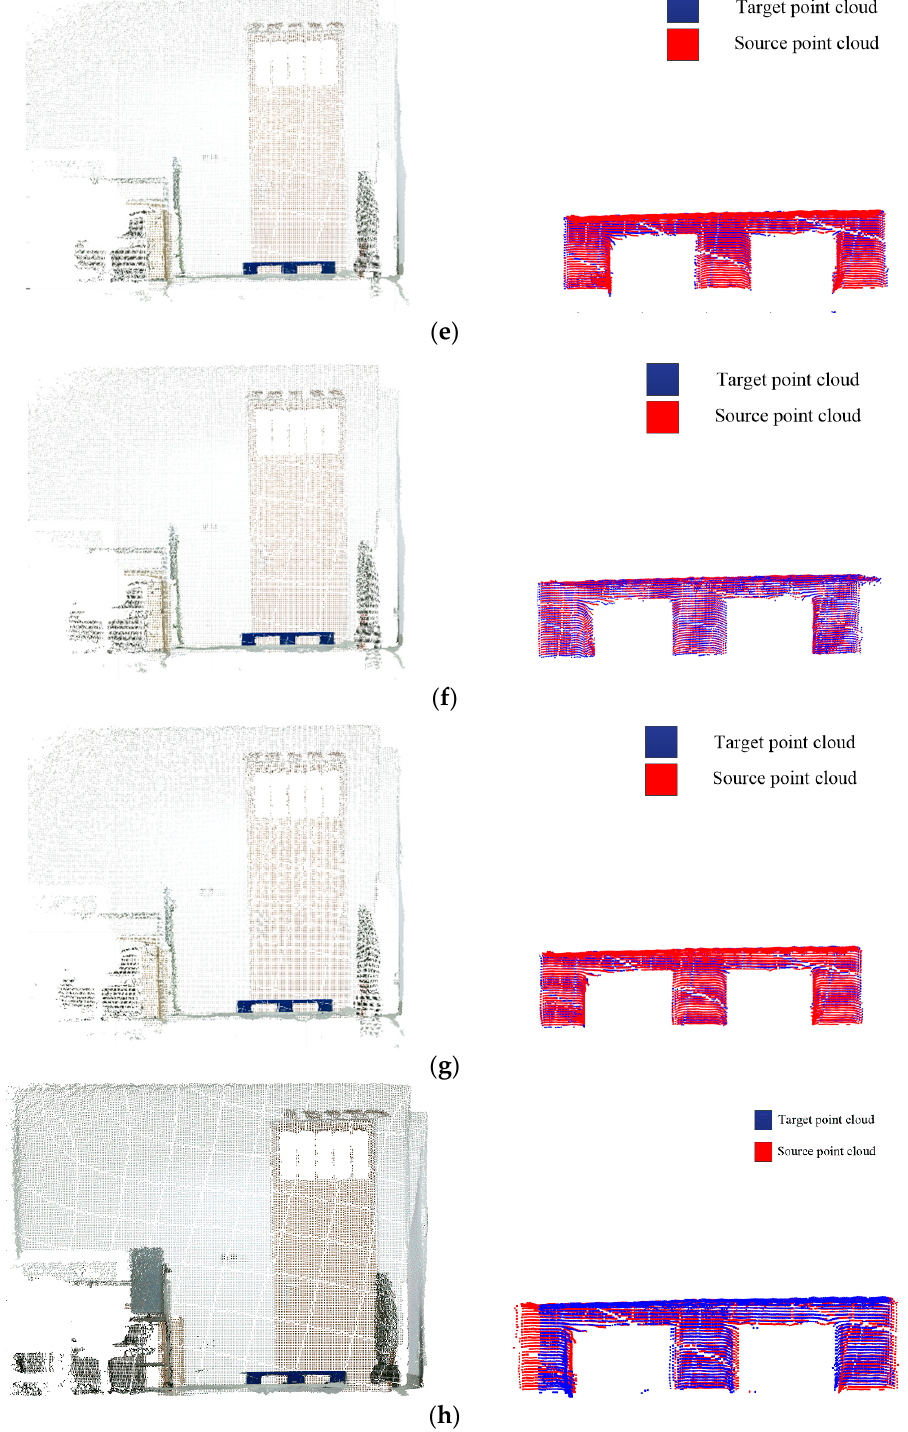
Figure 12. Scene point cloud and registration result. ( a ) 5° deflection angle. ( b ) 10° deflection angle. ( c ) 15° deflection angle. ( d ) 20° deflection angle. ( e ) Deviations of 0.05 m. ( f ) Deviations of 0.10 m. ( g ) Deviations of 0.15 m. ( h ) Deviations of 0.2 m.